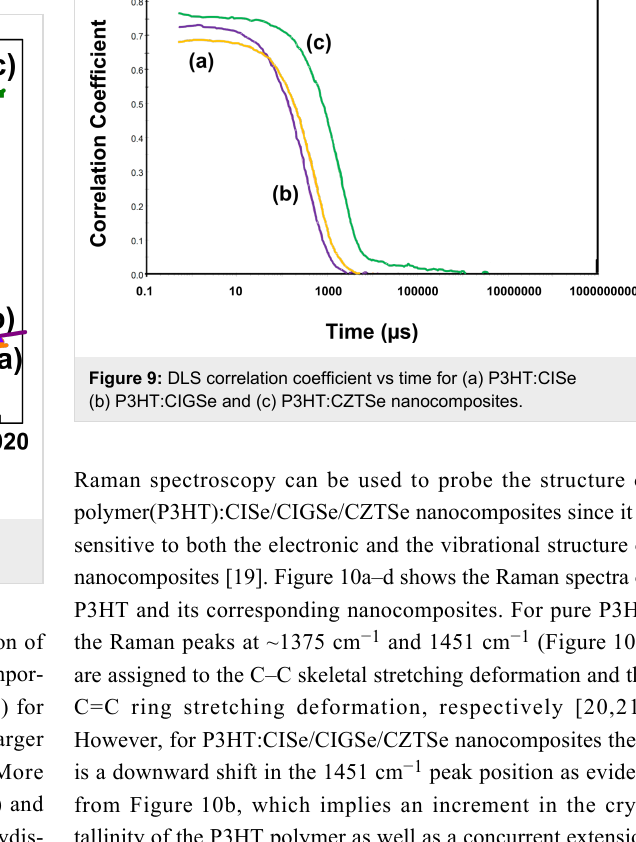
than the corresponding values determined by TEM. More